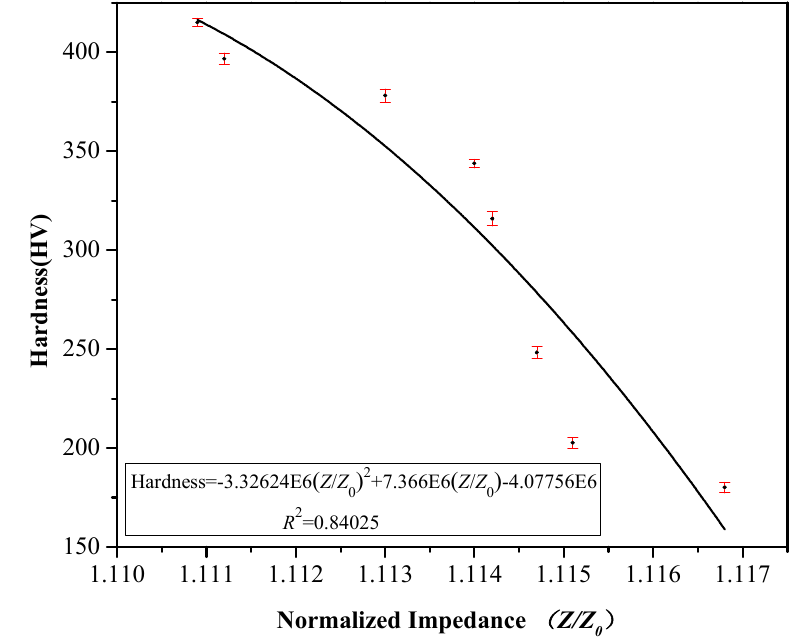
Figure 6. Relation between normalized impedance and hardness. Materials 2018 , 11 , x FOR PEER REVIEW